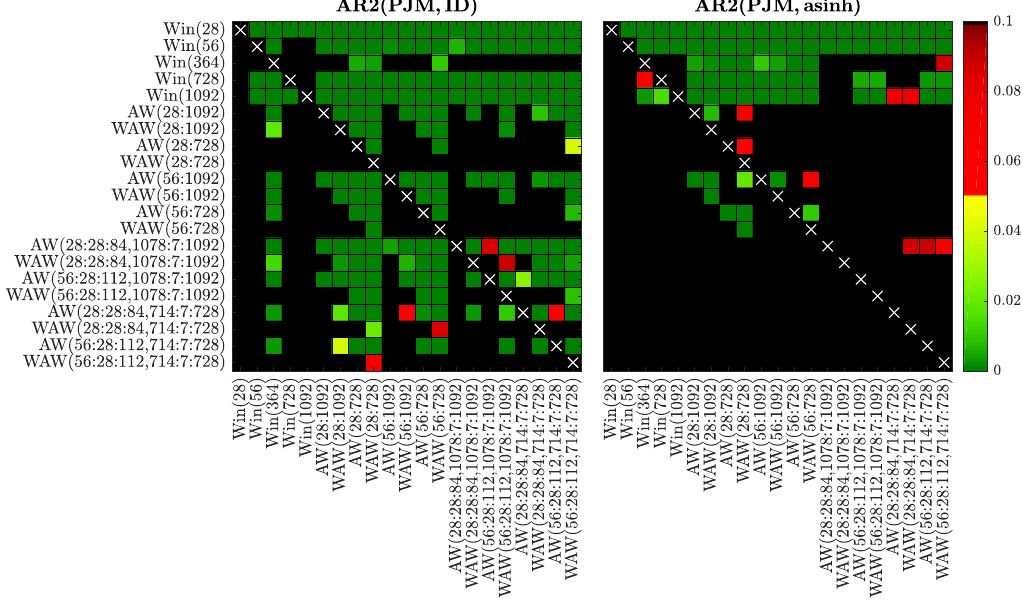
Figure 13. Results of the CPA test for selected window sets and the AR2 model fitted to raw ( left ) or asinh -transformed ( right ) PJM prices. We use a heat map to indicate the range of the p -values—the closer they are to zero ( → dark green) the more significant is the difference between the forecasts of a set on the X -axis (better) and the forecasts of a set on the Y -axis